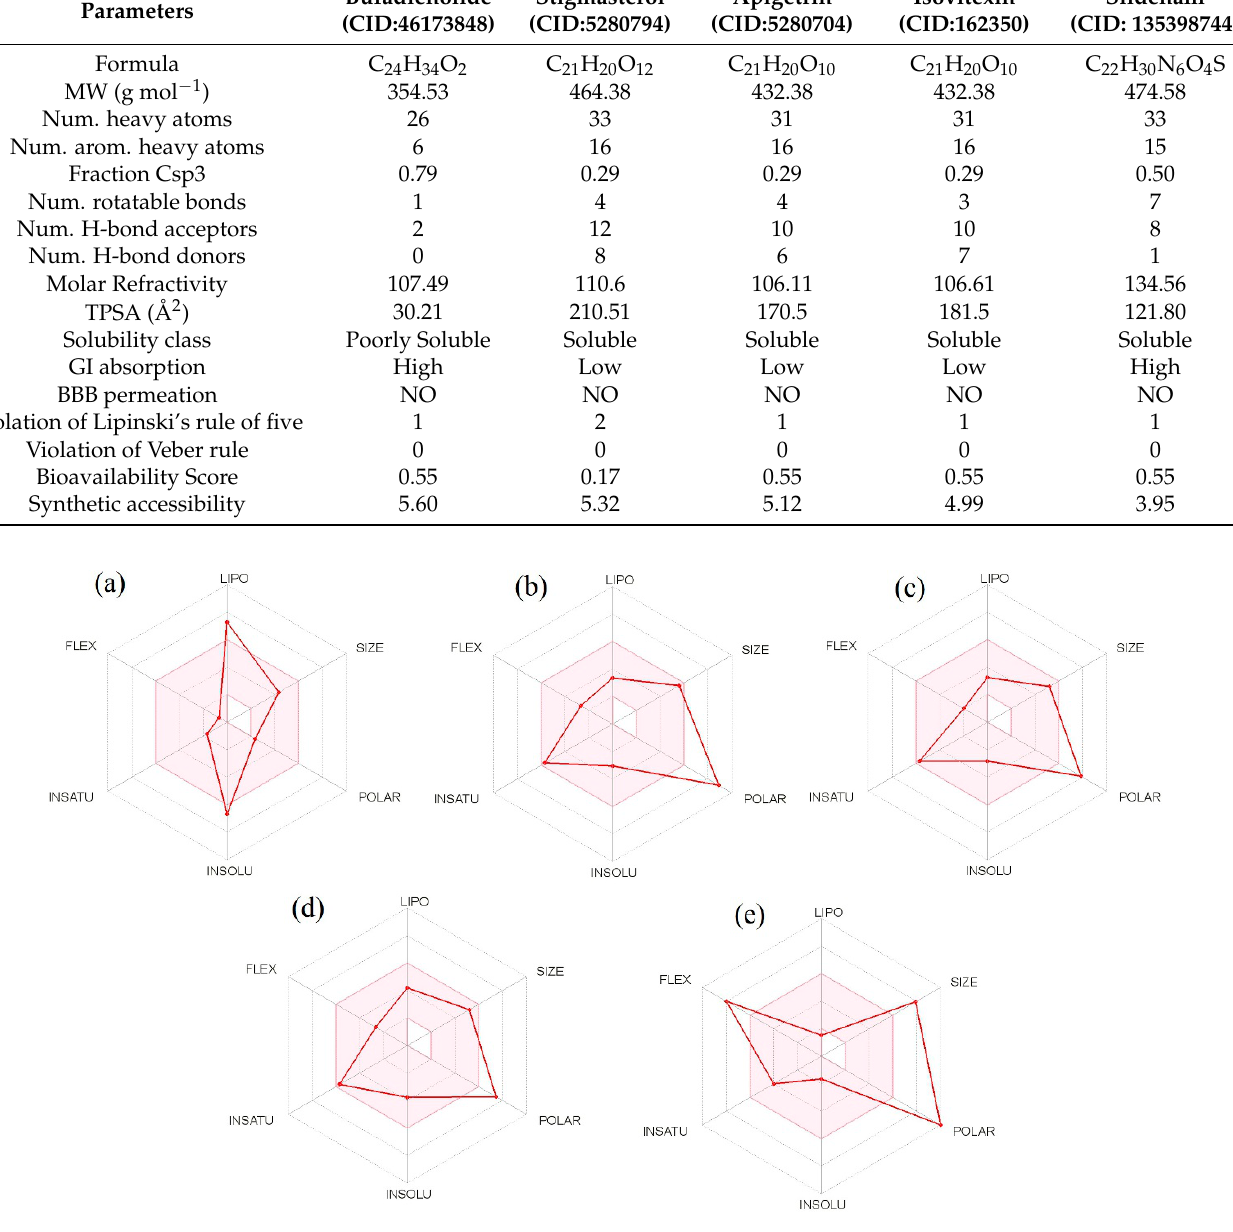
Figure 4. Bioavailability radar plot for oral bioavailability of top binding scored bioactive molecules: Bufadienolide ( a ), Stigmasterol ( b ), Isovitexin ( c ), Apigetrin ( d ), and standard PDE5 inhibitor sildenafil ( e ). The pink area exhibits the optimal range for each of the properties (Lipophilicity as XLOGP3 between − 0.7 and +5.0, size as molecular weight between 150 and 500 g mol − 1 , polarity as TPSA (topological polar surface area) between 20 and 130 Å 2 , insolubility in water by log S scale not higher than 6, saturation as per fraction of carbons in the sp3 hybridization not less than 0.25, and flexibility as per rotatable bonds no more than 9).